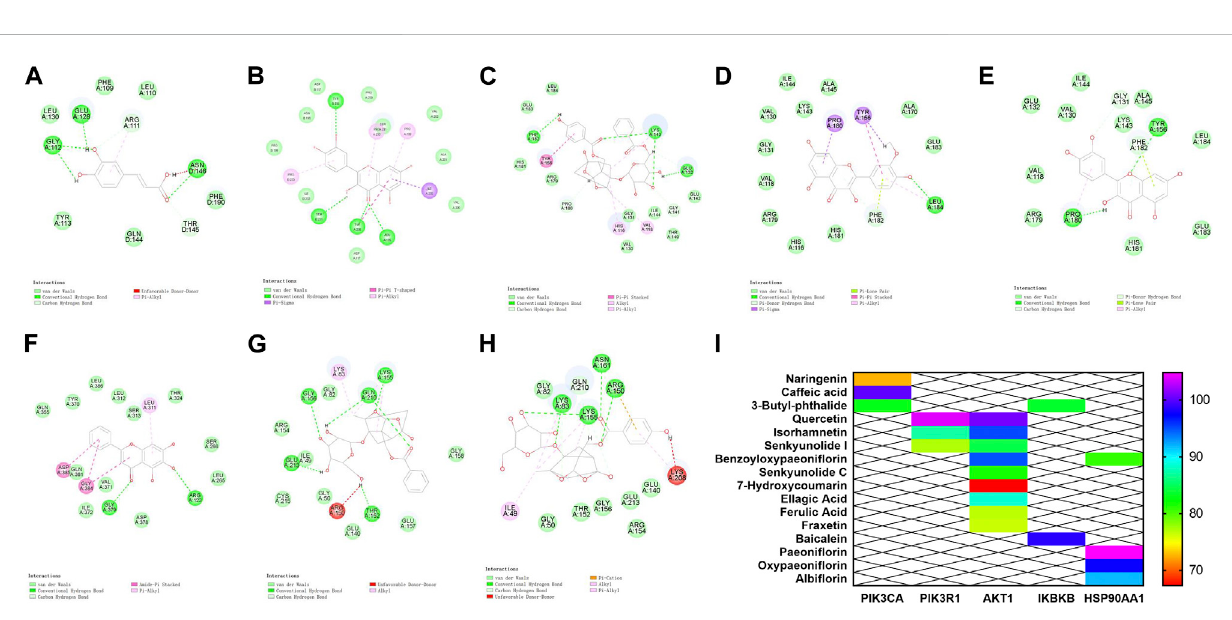
FIGURE 5 Molecular docking results. (A) PIK3CA and caffeic acid. (B) PIK3R1 and quercetin. (C – E) AKT1 target and benzoyloxypaeoni fl orin, isorhamnetin, and quercetin. (F) IKBKB target and baicalein. (G) HSP90AA1 and paeoni fl orin. (H) HSP90AA1 and oxypaeoni fl orin. (I) Heat map of molecular docking